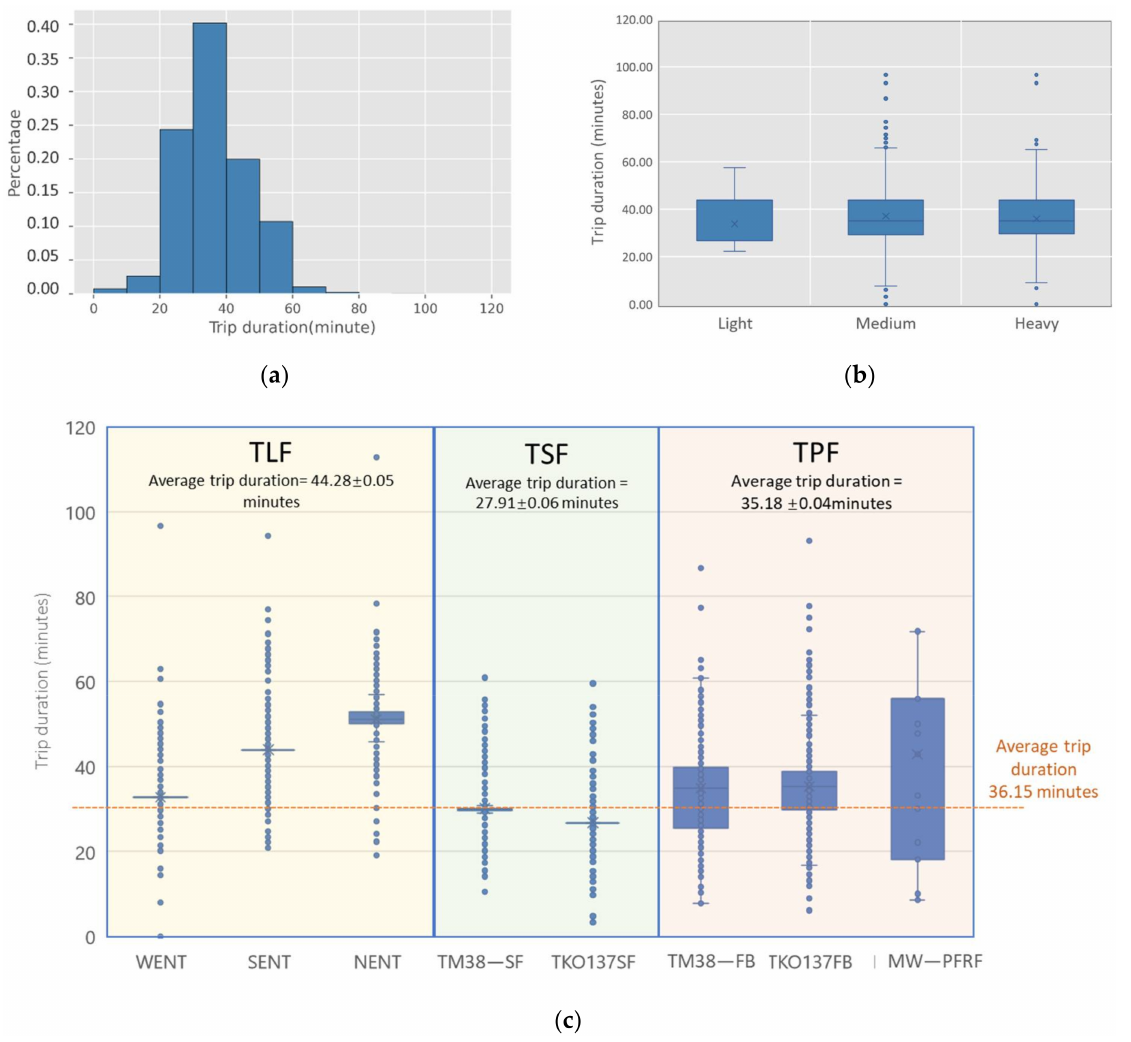
Figure 7. Trip duration of CWHTs: ( a ) trip duration histograms of CWHTs; ( b ) trip duration distribu- tion by vehicle types; ( c ) trip duration distribution by freight trip types. Notes: Average trip duration in ( c ) is presented as mean ± SEM (standard error of the